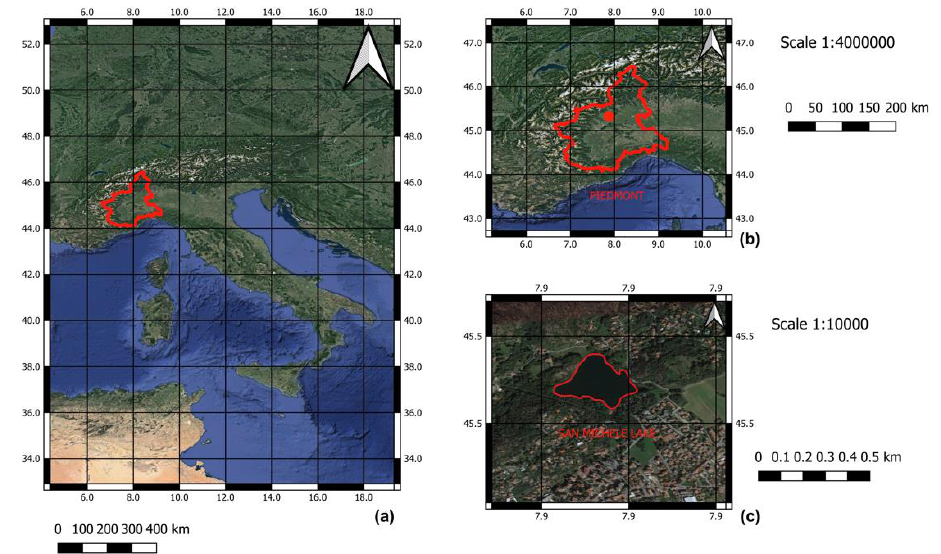
Figure 1. Sampling site: ( a ) Italy with insert, ( b ) Piedmont (outlined in red), and the location of ( c ) Lake San Michele (outlined in red; 45°28 ’ 39.1 ” N 7°53 ’ 18.2 ” E).